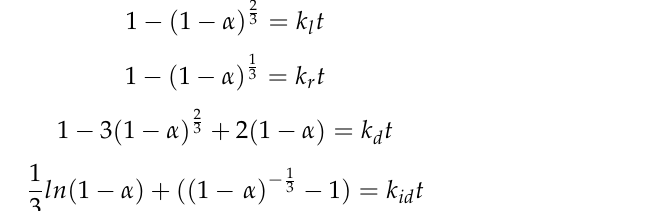
Figure 4. SEM and EDX mapping images of fluorapatite and dolomite before leaching ( a , b ) and after 90 min of leaching ( c , d